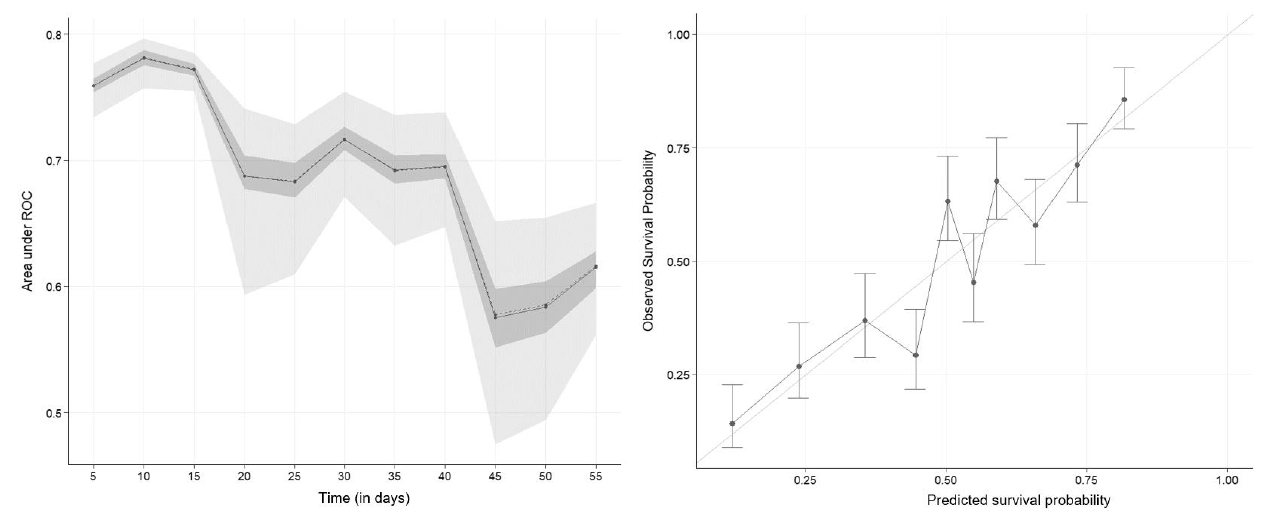
Figure 6. Time-dependent area under the receiver-operator curve (tAUC) (left graph) and calibration curve (right graph) at day 60 of a nomogram built with predictors from the clinical exam, predicting survival of dairy cows coming from 124 herds in Québec, Canada with severe clinical mastitis in function of time after first veterinary clinical evaluation. The values are based on 100 bootstrap samples. The solid line represents the mean of the tAUC, the dashed line represents the median of the tAUC. The darker interval in the plot shows the 25% and 75% quantiles of AUC, the lighter interval shows the minimum and maximum of